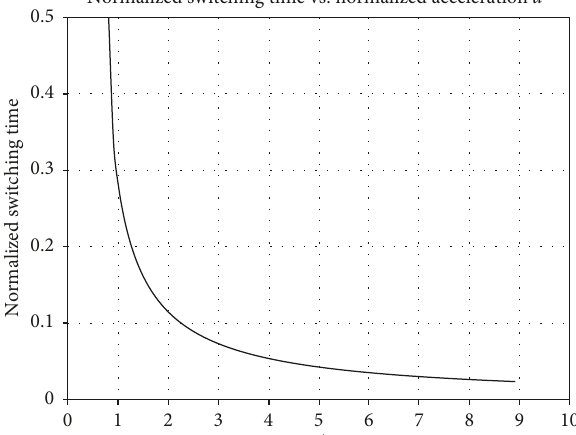
Figure 4: Switching time as a function of a ∗ in the case of externally dissipative